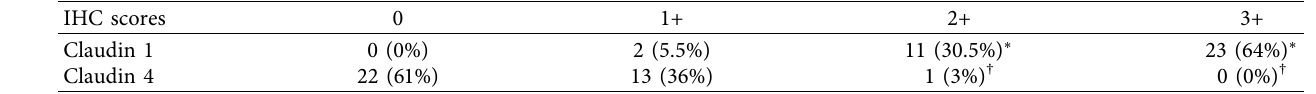
Table 3: Frequencies of claudin IHC scores in 36 basal cell